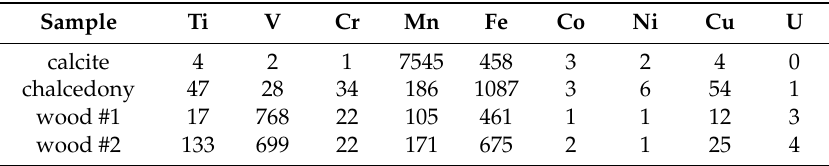
Table 3. Trace elements in Blue Forest geologic materials